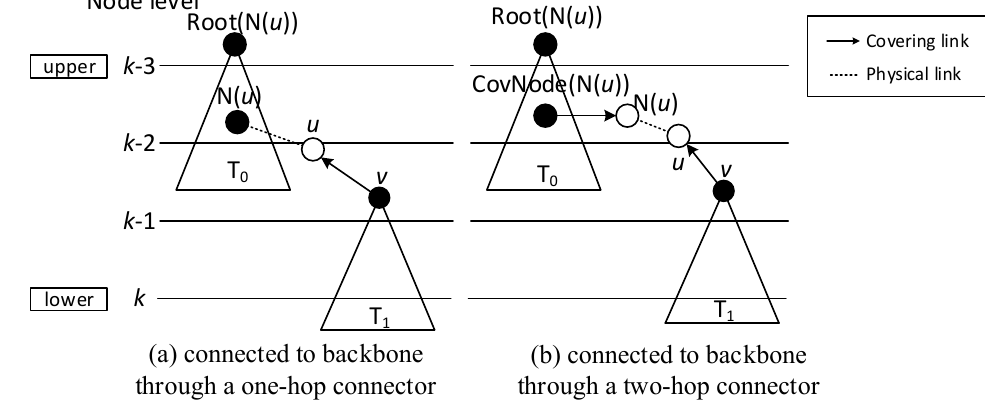
Figure 11. Case 3 in finalizing backbone.